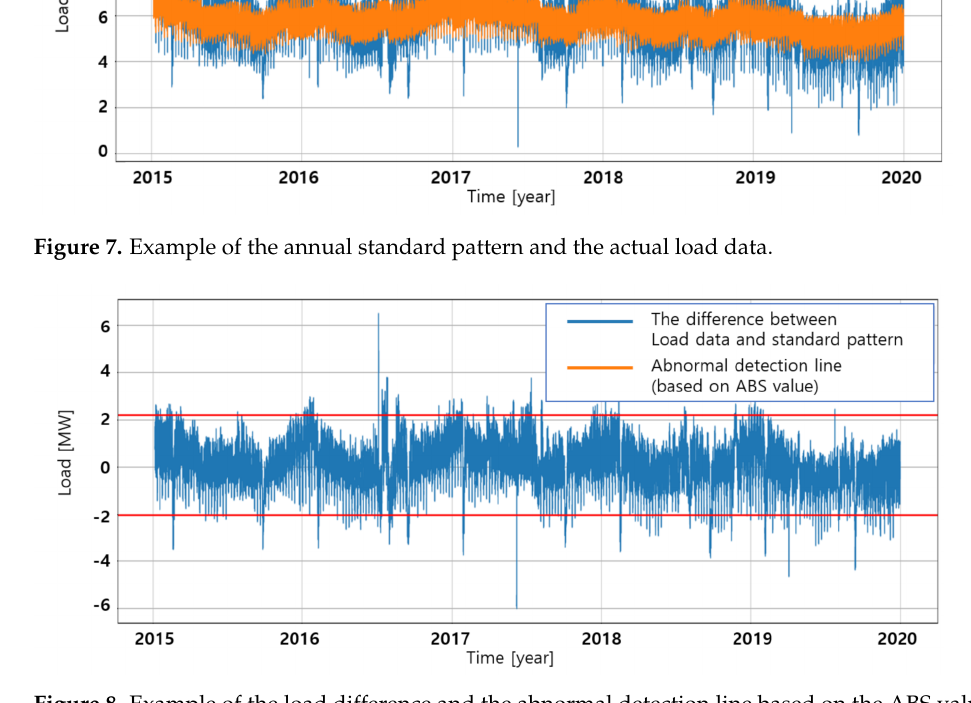
Figure 8. Example of the load difference and the abnormal detection line based on the ABS value.